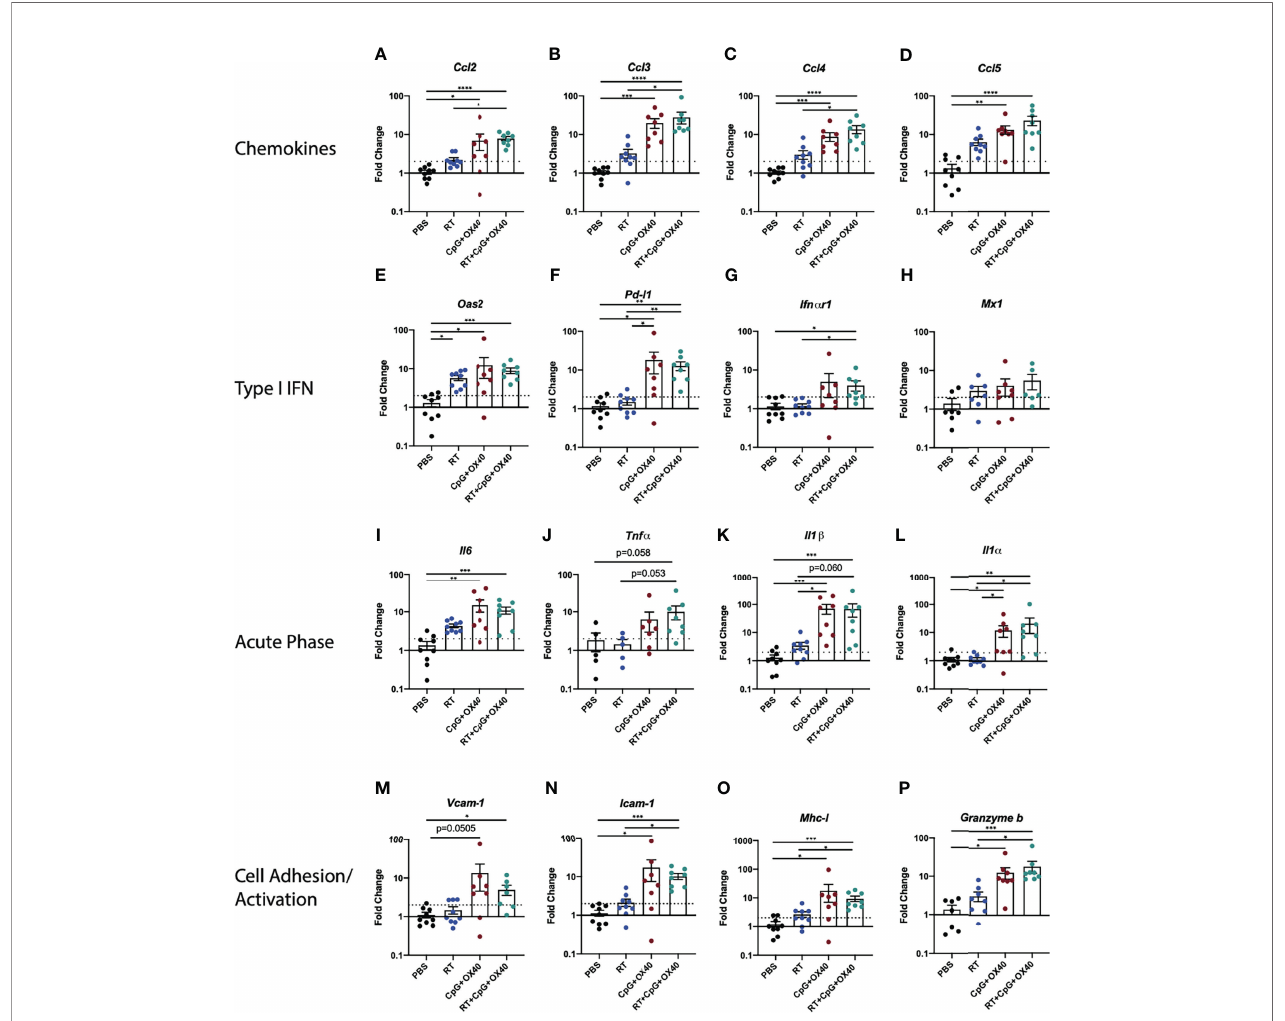
FIGURE 4 | RT+CpG+OX40 Modi fi es Gene Expression in TME for Favorable Anti-Tumor Response. Fold-change gene expression of (A – D) chemokines, (E – H) type I IFN pathway genes, (I – L) acute phase in fl ammatory cytokines, and (M – P) cell adhesion and immune activation genes in the B78 model on day 14 following treatment initiation with PBS (black), RT (blue), CpG+OX40 (red), and RT+CpG+OX40 (teal). Results are presented from a single set of qPCR analyses that were run simultaneously on tumor tissue samples collected from two independent experiments (n=7-10 total per group). For each gene of interest, signi fi cance was determined by Kruskal-Wallis testing; if signi fi cance was found groups were compared via a Dunn test and adjusted using the Holm method. *P ≤ 0.05; **P ≤ 0.01; ***P ≤ 0.001; ****P ≤